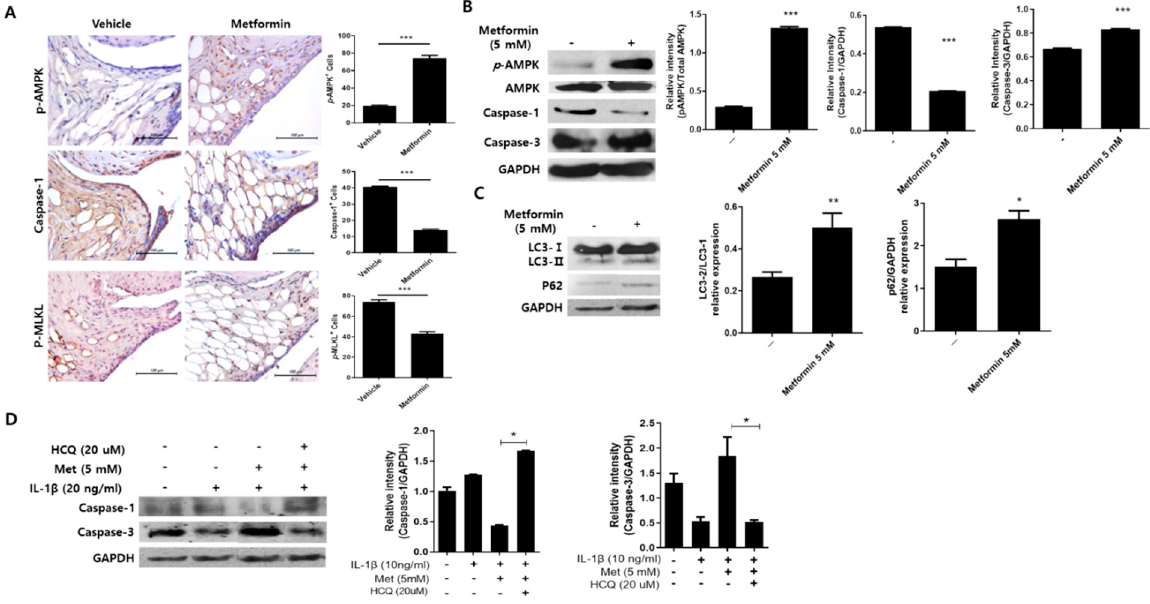
Figure 4. Expression of cell death mediators following metformin administration. ( A ) The expression of p-AMPK, caspase-1, and p-MLKL in the knee joint tissues of MIA-induced OA rats was determined immunohistochemically (N = 6 animals per group). The count of positive cells for each antibody is shown on the right. Human OA chondrocytes were cultured with metformin (5 mM) for 24 h. ( B , C ) p-AMPK, caspase-1, caspase-3, LC3, p62, and GAPDH were analyzed using Western blot in the protein of metformin-treated human chondrocytes. ( D ) The human OA chondrocytes were cultured with metformin (5 mM), IL-1 β (20 ng/mL), and HCQ (20 μ M) for 24 h. Caspase-1, caspase-3, and GAPDH were analyzed using Western blot. Data are represented as the mean ± SEM of three independent experiments (* p < 0.05, ** p < 0.01, *** p < 0.001). 3.6. Metformin Promotes Autophagy in Human Chondrocytes Human OA chondrocytes stimulated by IL-1 β were examined for autophag- olysosome markers by immunofluorescence staining. The number of LC3B- and LAMP1-positive cells increased in the metformin-treated group compared with the IL-1 β -stimulated group (Figure 5A,B). These findings indicate that metformin regulates the expression of autophagolysosome markers in chondrocytes. 3.7. The Effect of the Combination of Metformin and Celecoxib in OA Progression It is well known that celeccoxib has a therapeutic effect in OA [21]. In this study, we investigated the effect of metformin and celecoxib combined on OA progression. To address that, we administrated a combination of metformin and celecoxib to MIA-induced OA rats. Cartilage damage was dramatically improved in the metformin and celecoxib combination-treated group (Figure 6A,B). This re- sult shows the therapeutic potential of cotreatement of metformin and celecoxib in OA.